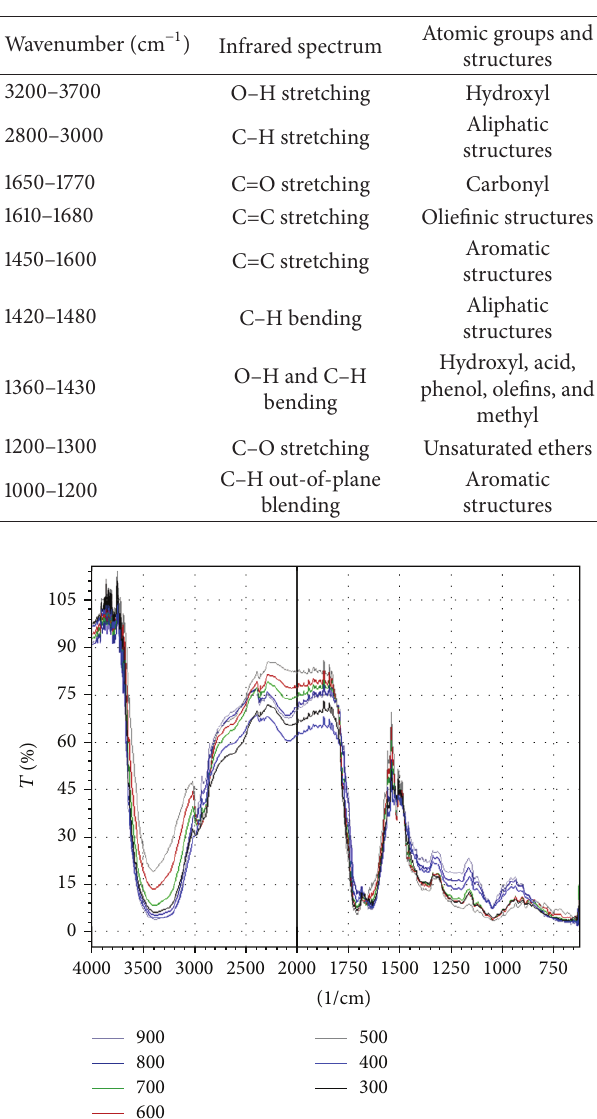
Figure 9: FT-IR spectrum of pyro-oil obtained at different pyrolysis